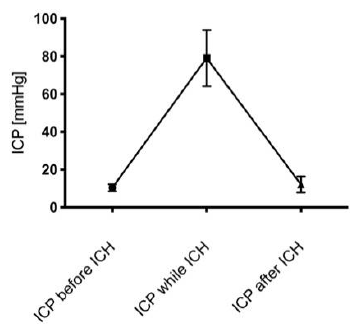
Figure A3. Intracranial pressure (ICP) (control Group n = 3; treatment groups (2–4); each n = 6). The means and SD of the ICP before, while and after ICH induction are plotted.